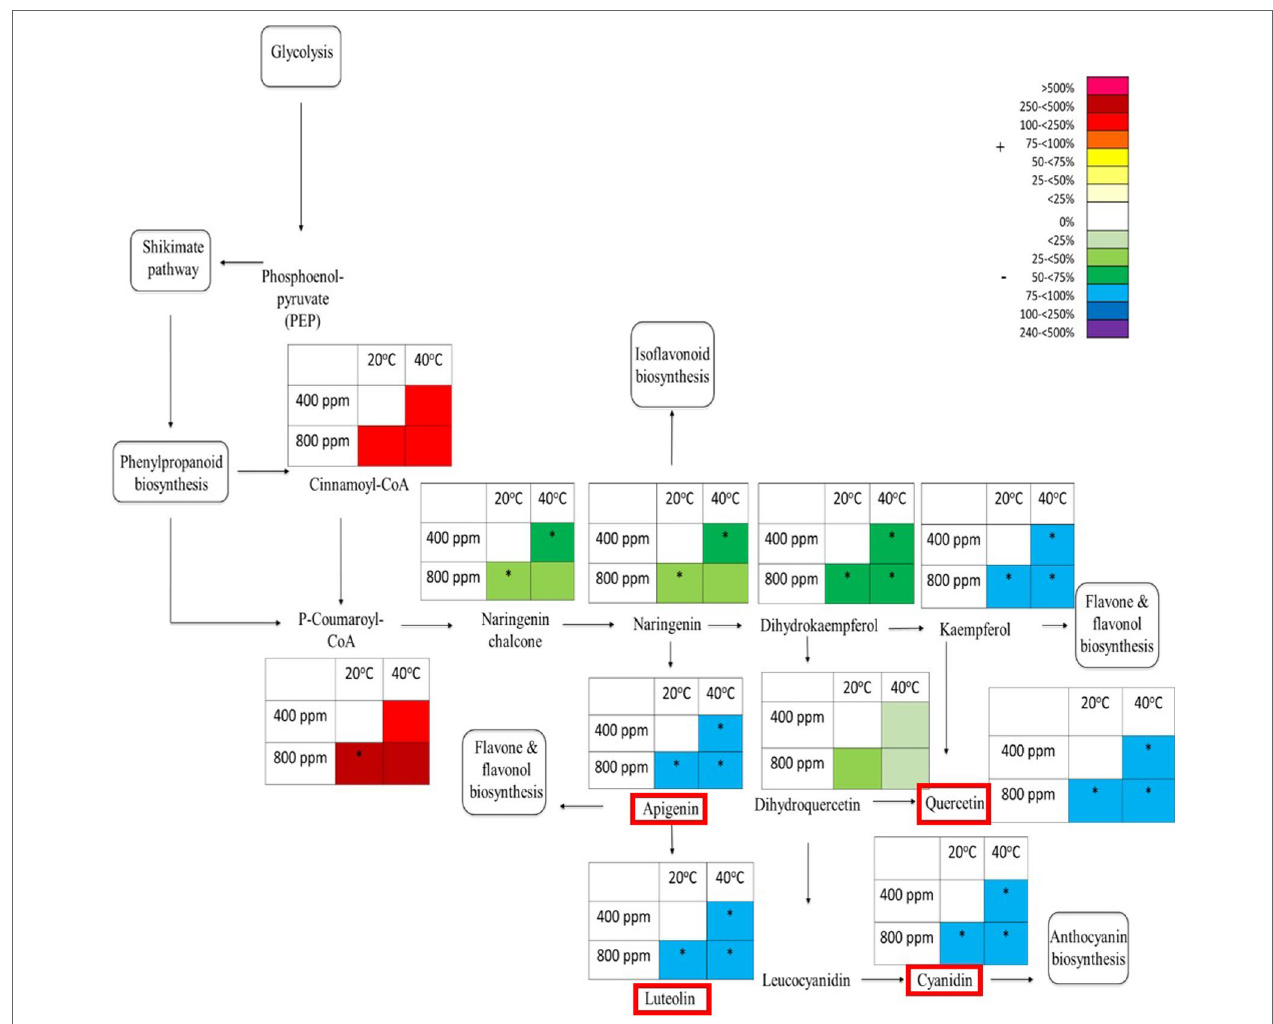
FIgURE 5 | Schematic pathway diagram of glycolytic, shikimate, phenylpropanoid and flavonoid biosynthesis. The tables show abundance of the metabolites calculated from the % total ion count for data from MALDI-ToF analysis (polar phase analysed in negative ionisation mode). * indicates statistically significant changes in % differences of the total ion count relative to treatment. The % bar scale shows increase or decrease in abundance of %TIC. Red boxes around specific secondary metabolites indicate identification using tandem MS against an analytical standard. Each point in the table for each metabolite represents a pooled replicate per plant across the four